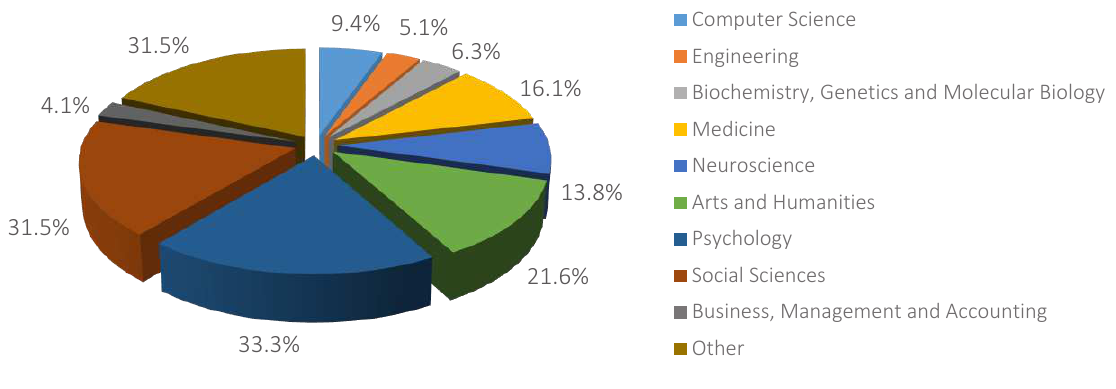
Figure 2. Structural analysis of the concept of “sustainability reporting” by subject